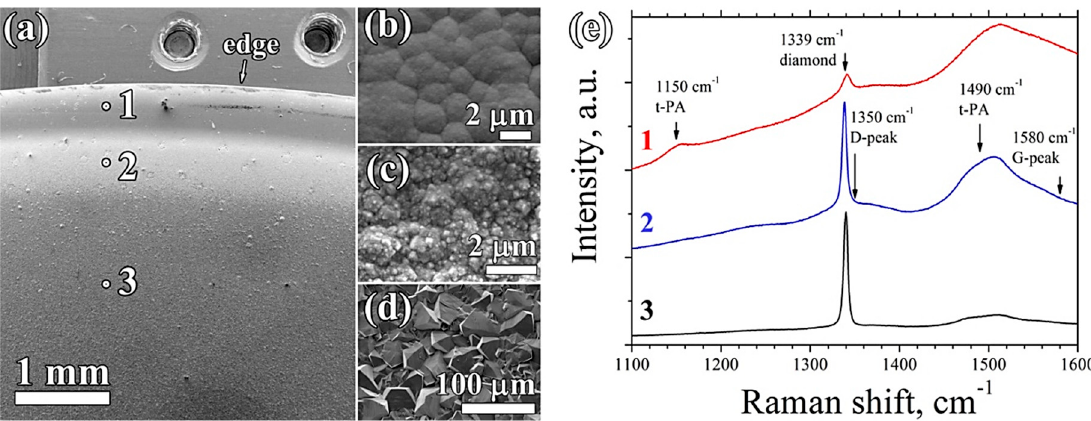
Figure 4. SEM images of the surface of PCD film grown with MPCVD technique in pocket substrate holder: ( a ) general view of PCD surface near the edge area; ( b – d ) close-up pictures from points 1–3; ( e ) Raman spectra taken from points 1–3.